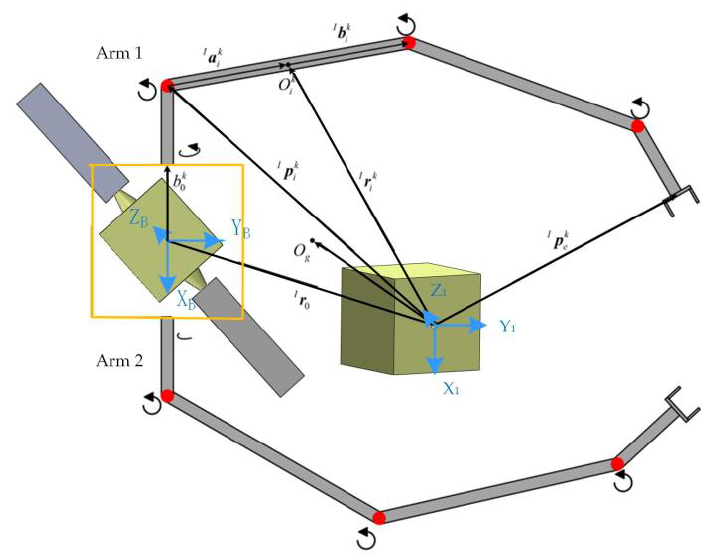
Figure 10. Schematic diagram of free-floating dual-arm space robot arm capture.